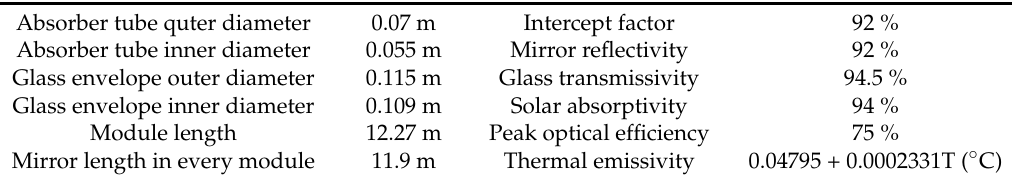
Table 2. Geometrical and optical parameters for the collector loop